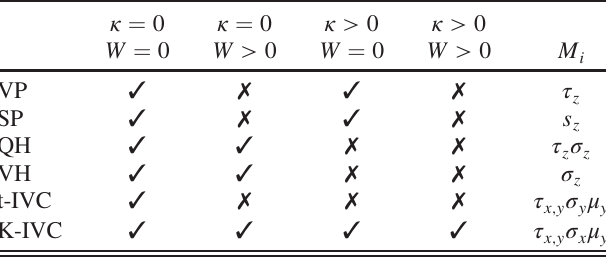
TABLE II. Order parameters and regimes where the correspond- ing symmetry-broken phases are favored for the parameters ð κ ; W Þ in the strong coupling limit [27], i.e., small dispersion limit. In the last column, microscopic operators are listed for each order parameter. In the chiral limit with a dispersionless (flat) band, i.e., ð κ ; W Þ ¼ ð 0 ; 0 Þ ,the system has U ð 4 Þ × U ð 4 Þ global symmetry [27]. Accordingly, symmetry-broken states for the listed order parameters become degenerate. For W > 0 , the finite dispersion gives rise to an antiferromagnetic coupling between different Chern sectors and disfavors the SP, VP, and t-IVC states. For κ > 0 , the deviation from the chiral limit gives rise to intersu- blattice interactions, which disfavors QH, VH, and t-IVC states. Combining both perturbations, the K-IVC becomes the most favored state among the listed symmetry-broken states. This qualitative behavior agrees with the observations in Fig.